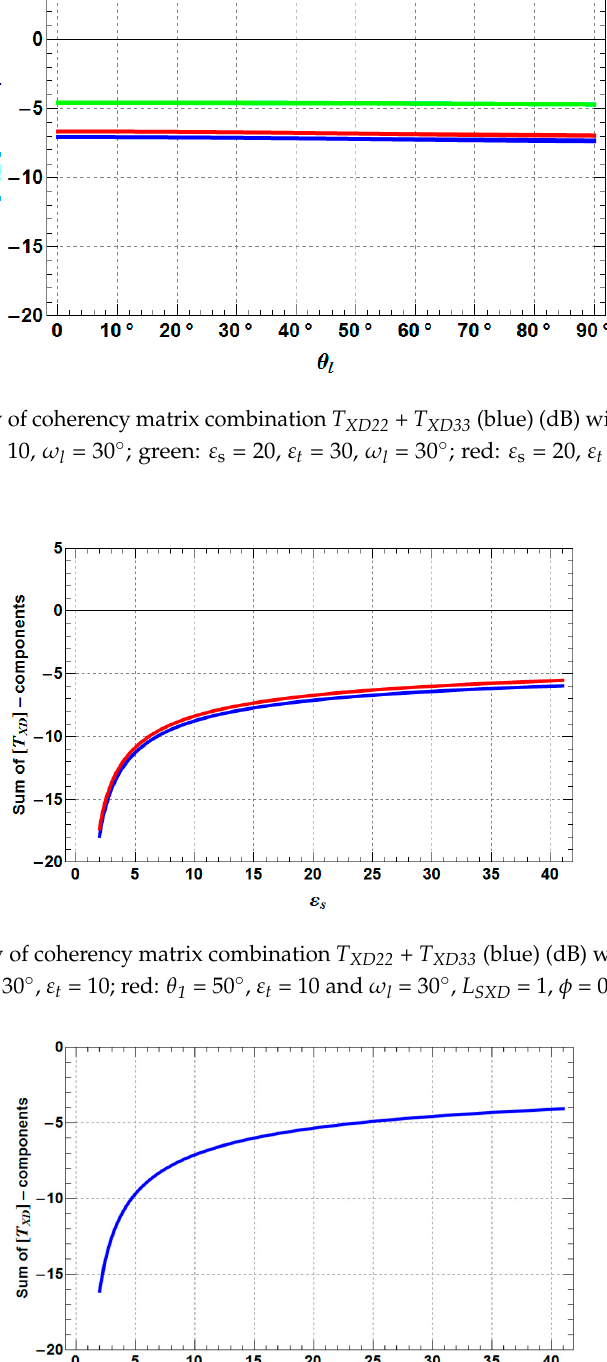
Figure 18. Sensitivity of coherency matrix combination T XD22 + T XD33 (blue) (dB) with the dielectric of